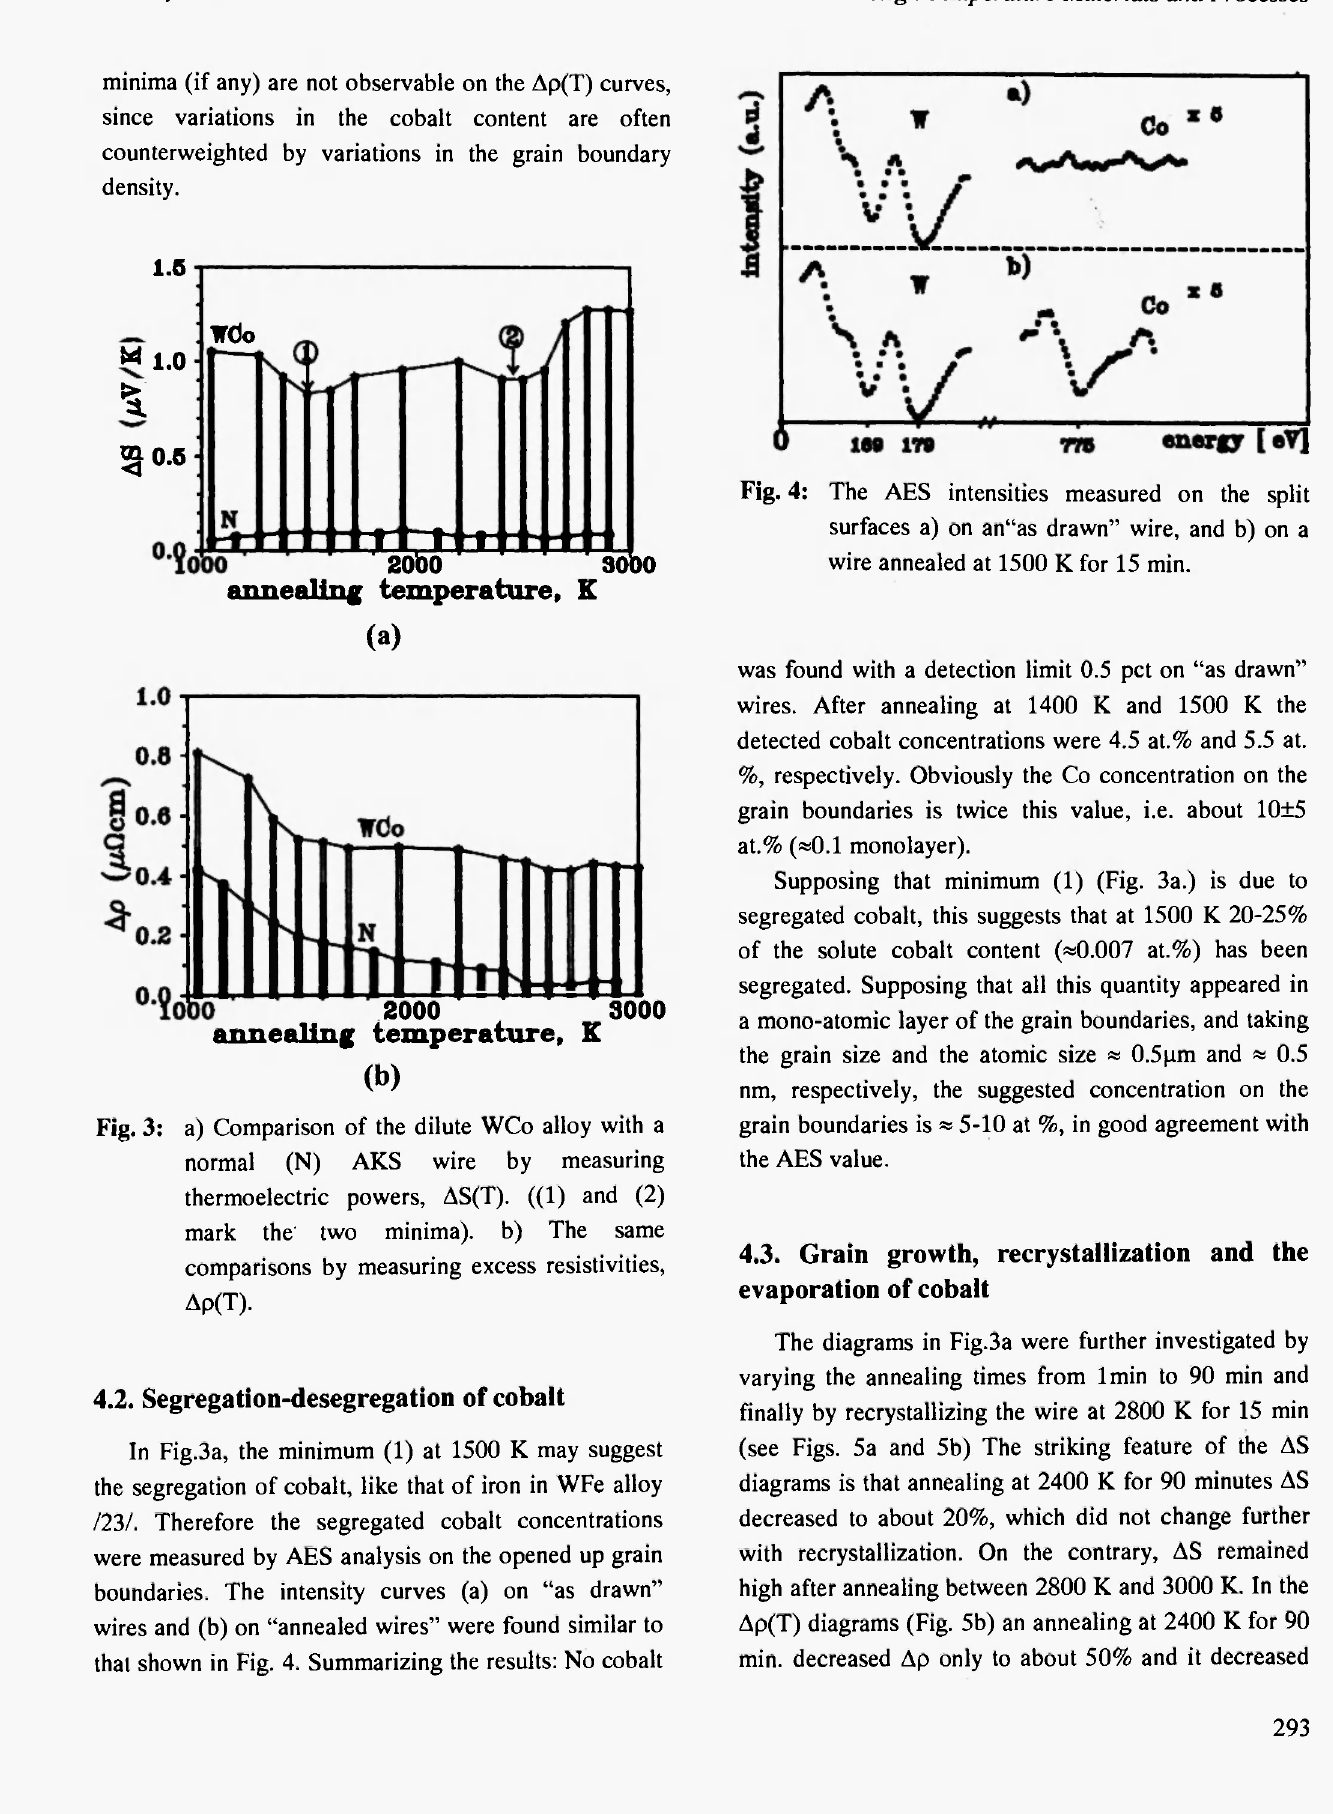
Fig. 4: The AES intensities measured on the split surfaces a) on an"as drawn" wire, and b) on a wire annealed at 1500 Κ for 15